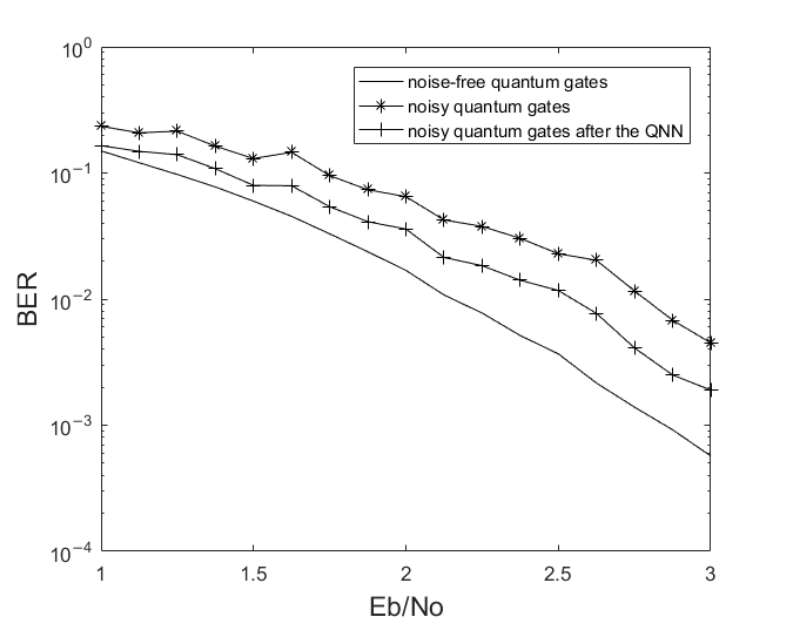
Figure 9. The BER of the [6, 2, 2] quantum convolutional codes applying the QNN compared with BER before training and the noiseless quantum